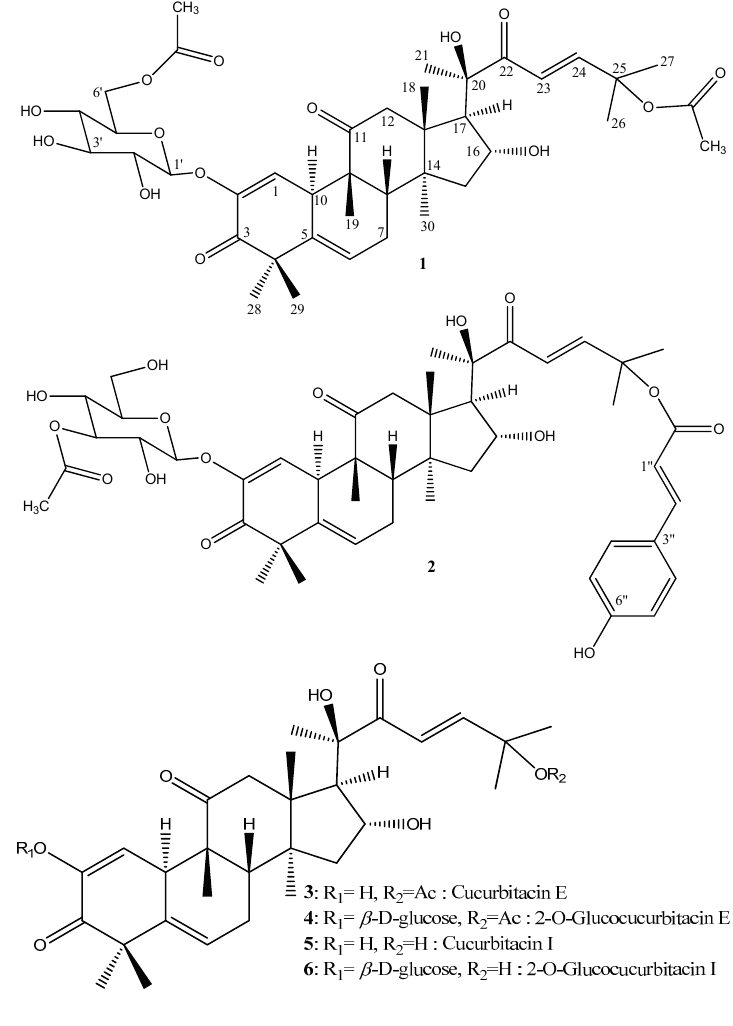
Figure 1. Structures of compounds 1 – 6